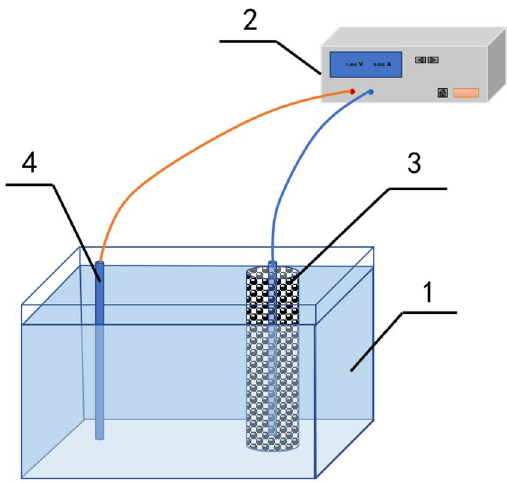
Figure 1. The experimental apparatus used in this study. 1, electrolytic cell; 2, DC power supply; 3, cathode: biochar electrode; 4, anode: graphite rod.